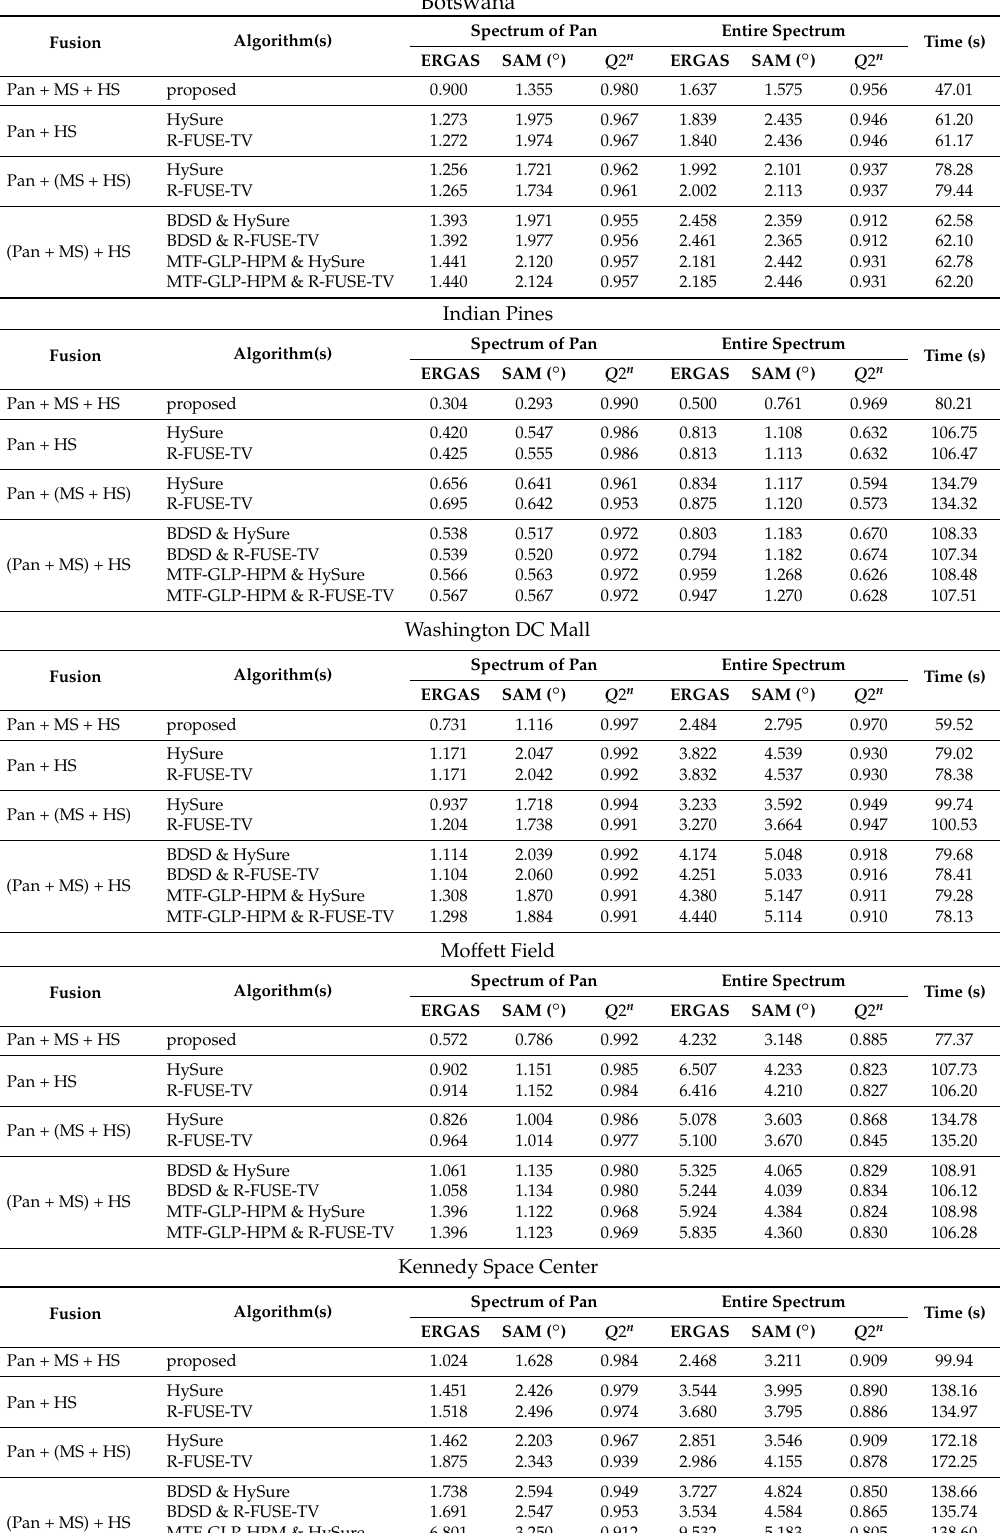
Table 2. The values of the performance metrics for assessing the fusion quality as well as the runtimes of the considered algorithms for different